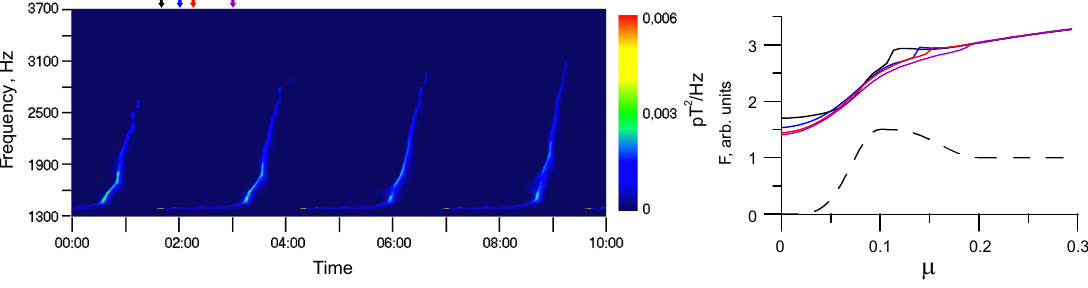
Fig. 7. The same as in Fig. 6 but for wider peak on the source pitch angle distribution: æ 1 = 0 . 1. More intense and longer generation of low frequency waves at the beginning of the spike